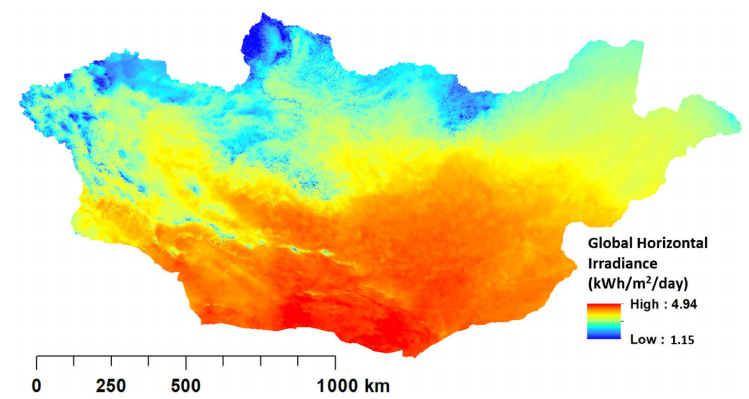
Figure 3. Global horizontal irradiance of